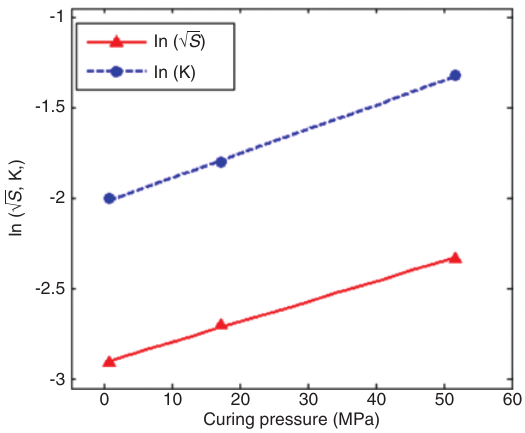
Figure 6: Pressure dependence of fitted model parameters (Class H cement, w/c = 0.38).